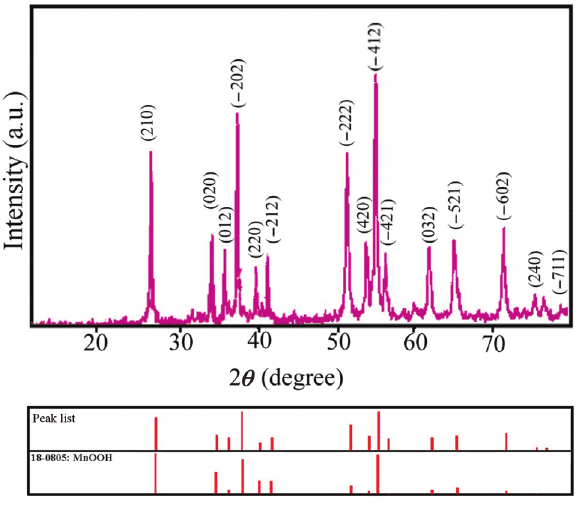
Figure 1: XRD pattern of sample no. 1.